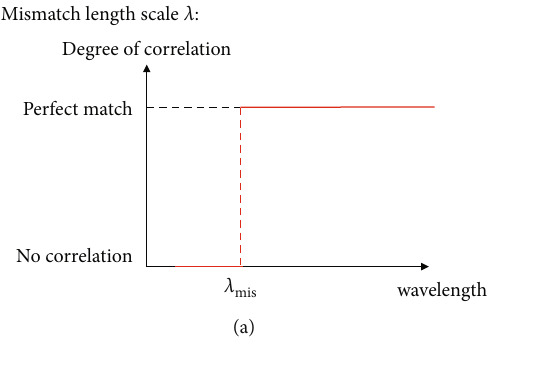
The upper frequency end, q where λ is the smallest representable or measurable size. The 1 lower frequency end, q λ is the surface length. L